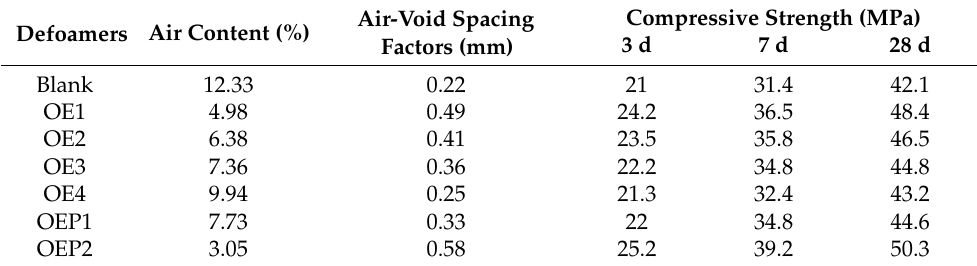
Table 5. Performance of the hardened mortar samples mixed with various defoamers.